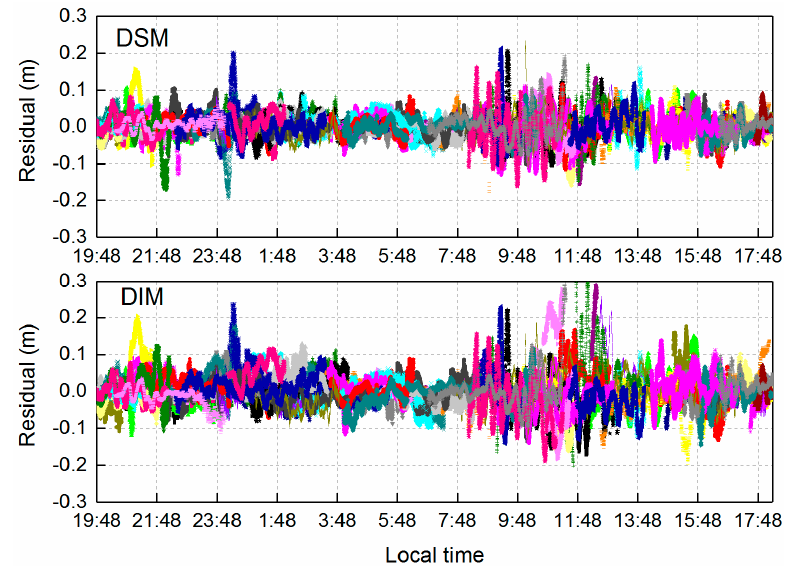
Figure 8. Time series of SD ionospheric residuals of DIM and DSM in large-scale networks. Different colors represent SD ionospheric residuals of different satellite pairs.